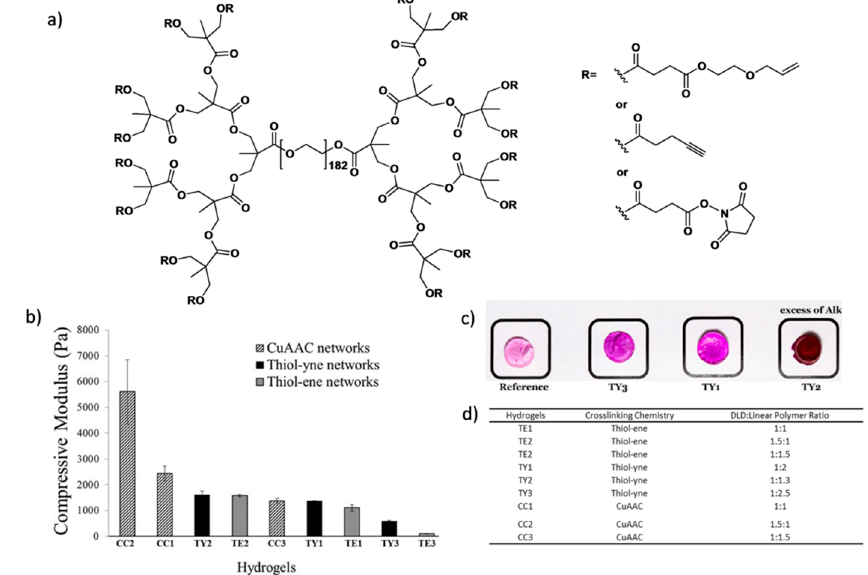
Figure 18. ( a ) Allyl, acetylene or N -hydroxy succinimide (NHS) functional dendron polymer conjugates; ( b ) compressive modulus values of the obtained hydrogels; ( c ) post-gelation functionalization of thiol-yne (TY) hydrogels with azide functional rhodamine (reference sample prepared by TY1 hydrogel without Cu(II)SO 4 catalyst); ( d ) definition of hydrogels. From [46], Copyright © 2015 by John Wiley & Sons, Inc. Adapted by permission of John Wiley & Sons, Inc. CuAAC, copper-catalyzed azide-alkyne